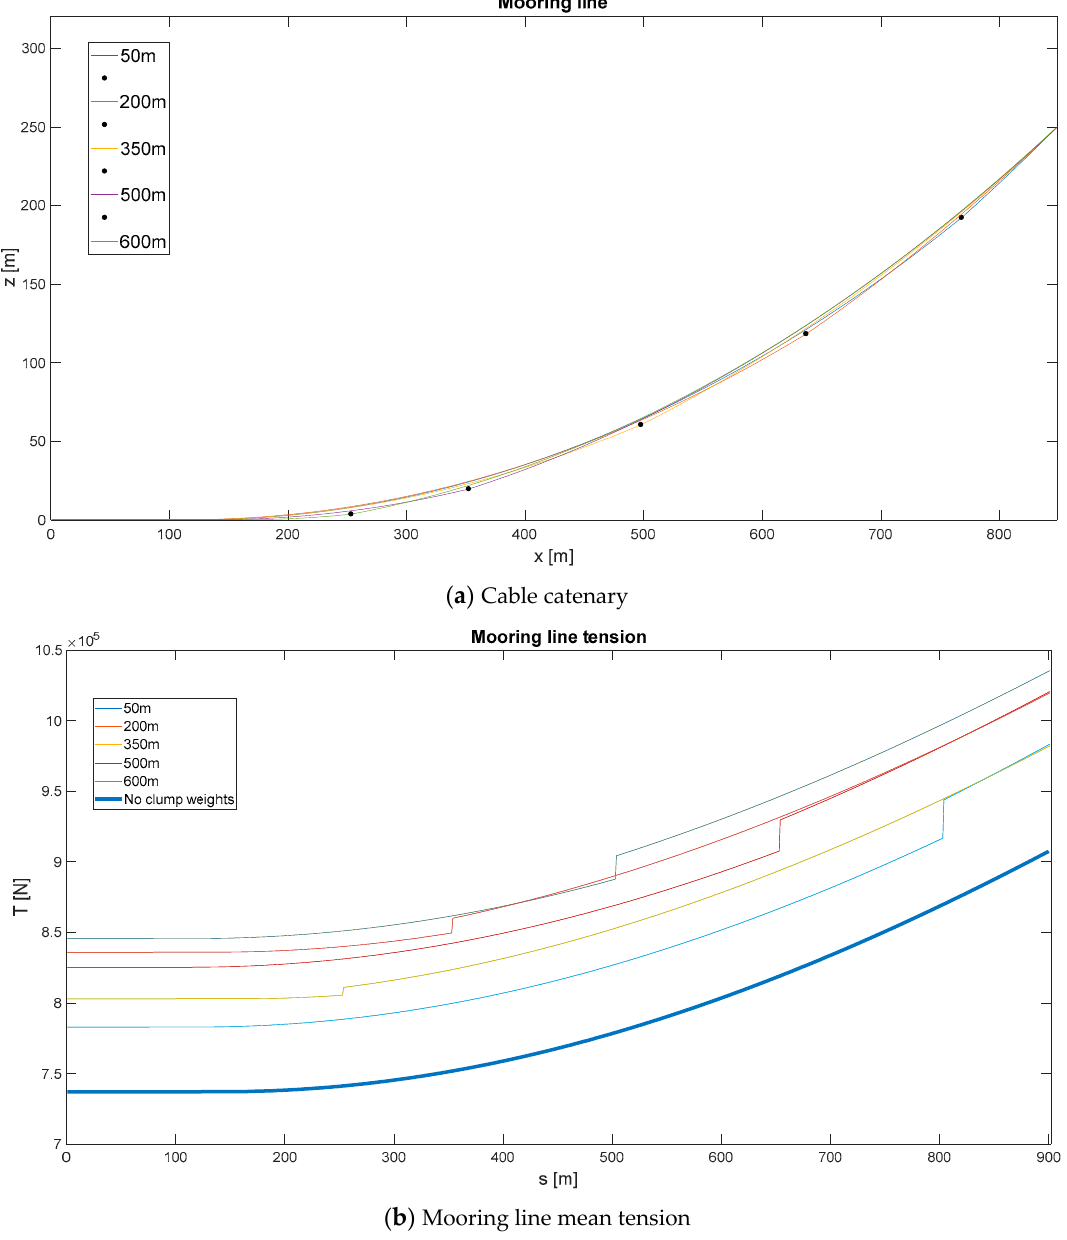
Figure 8. Cable catenary and mooring line tension depending on the ballast position (M = 5 t).